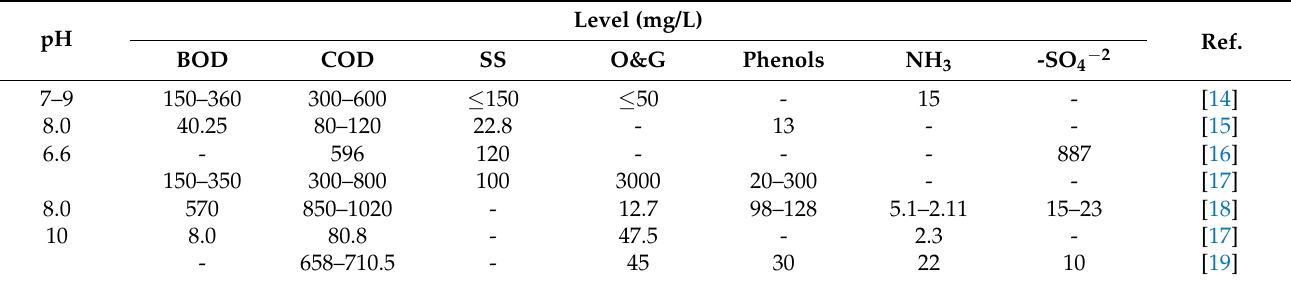
Table 1. Typical composition of refinery